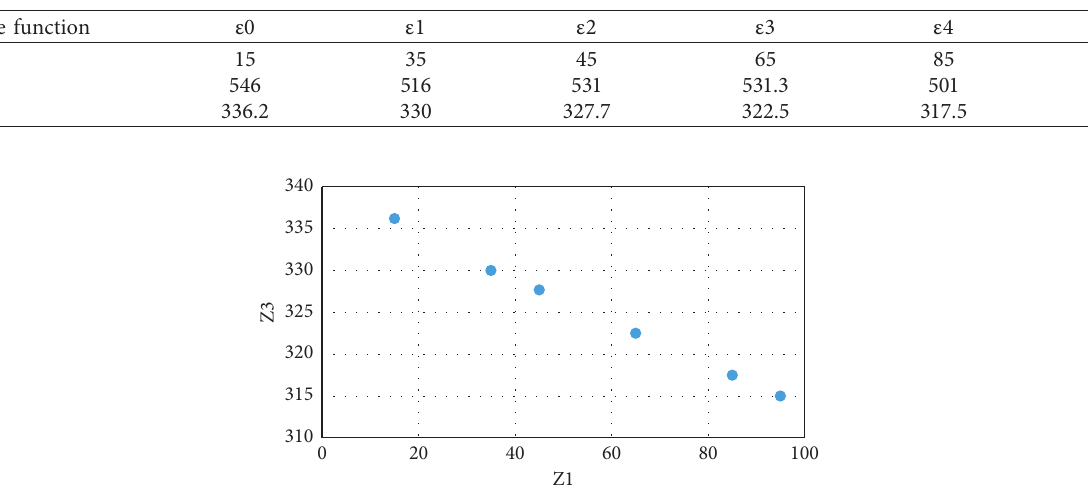
Figure 4: Pareto solutions of Z